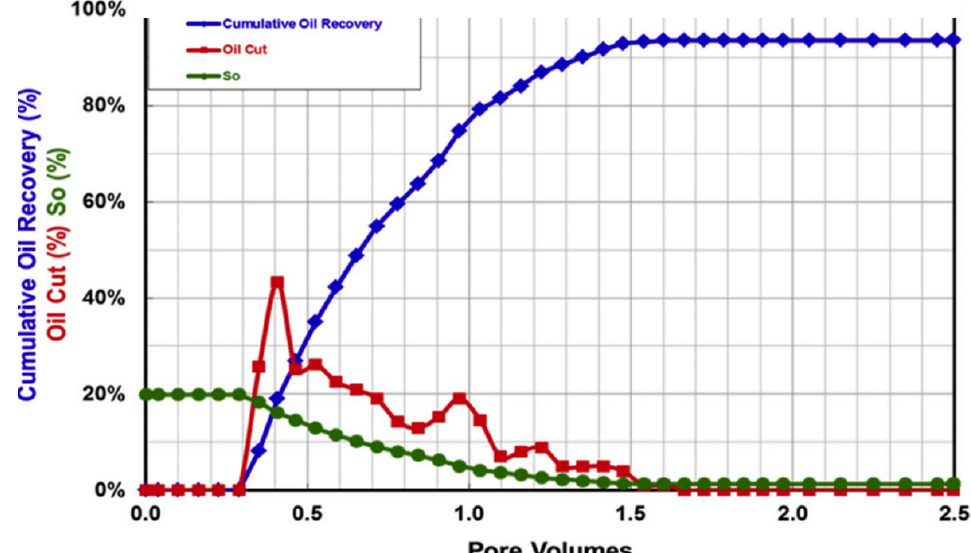
Figure 10. Coreflood results, depicting the oil cut, cumulative oil recovery and the remaining oil satu- ration (S o ) plotted against the injected pore volumes (Reprinted with permission from Abalkhail et al., 2020